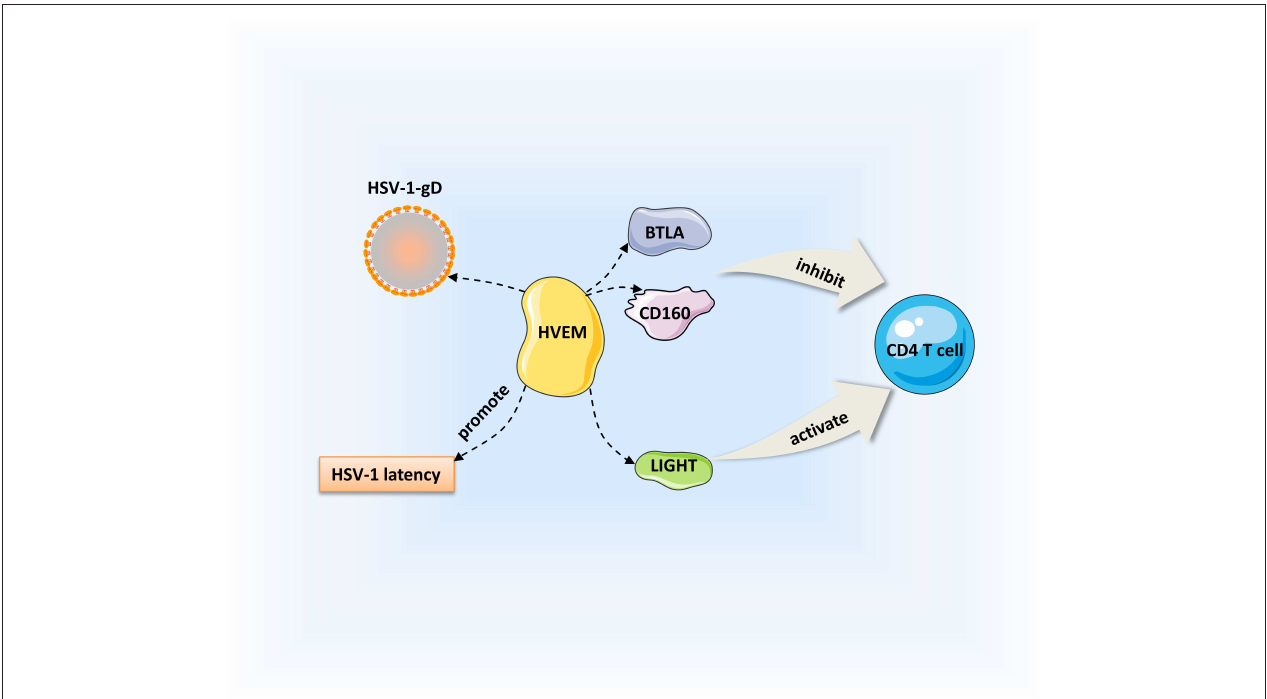
FIGURE 2 | Regulation of HSK by HVEM. HVEM can interact with immunoglobulin ligands [CD160, B, and T lymphocyte attenuator (BTLA)] and the tumor necrosis factor (TNF) ligand [LIGHT]. Binding of HVEM to LIGHT activates CD4 + T cells. Conversely, the interactions of CD160 and BTLA with HVEM inhibit CD4 + T cell expression. Besides, HVEM can promote the establishment of HSV-1